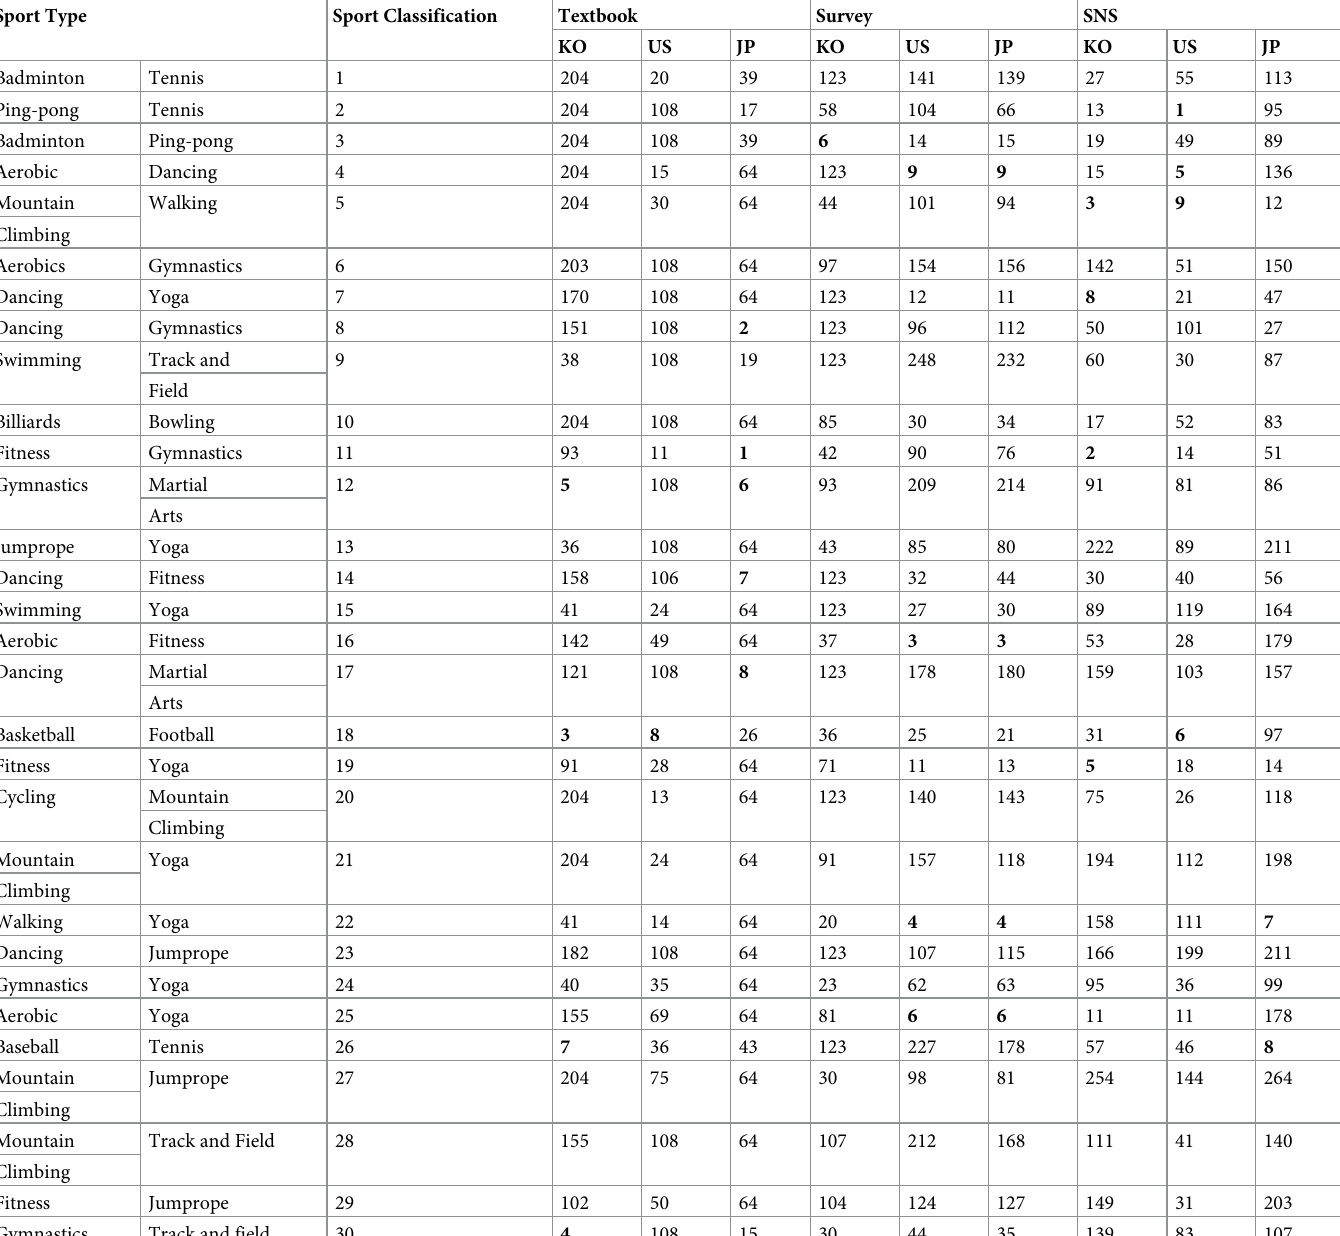
Table 9. Ranking of pairs (Top 30—Sport